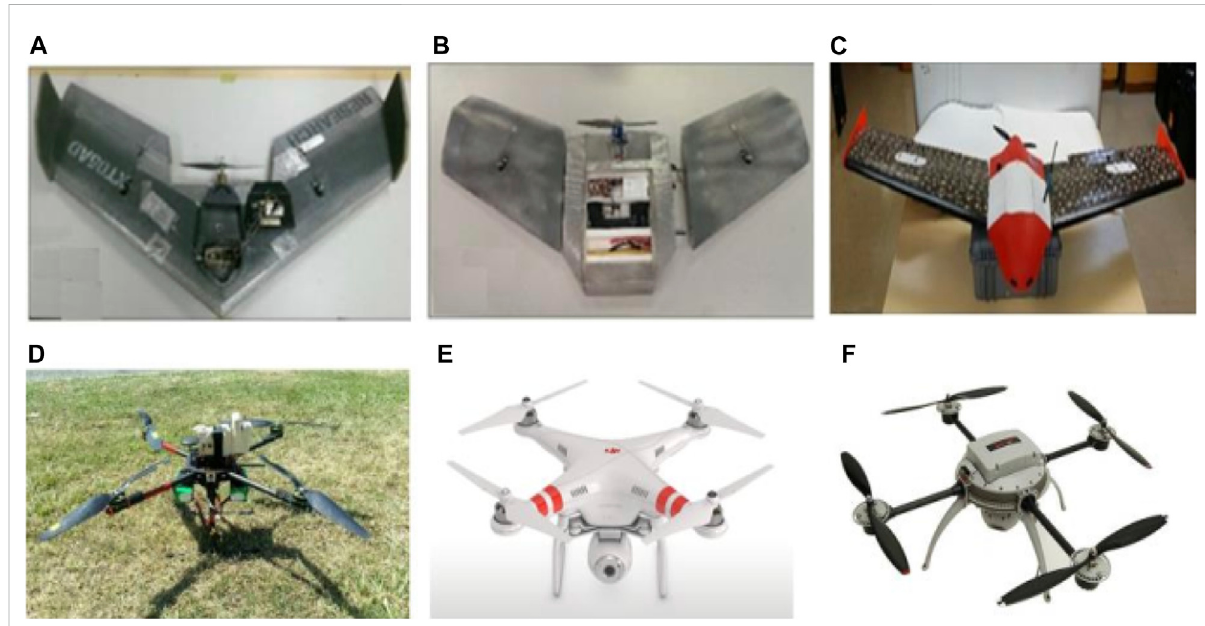
FIGURE 2 Drones commonlyutilizedintheminingindustry(Espositoetal.,2017): (A) Teklite, (B) GoSurv, (C) Swampfox, (D) Quadcopter, (E) Phantom2+ Vision, (F) Aeryon